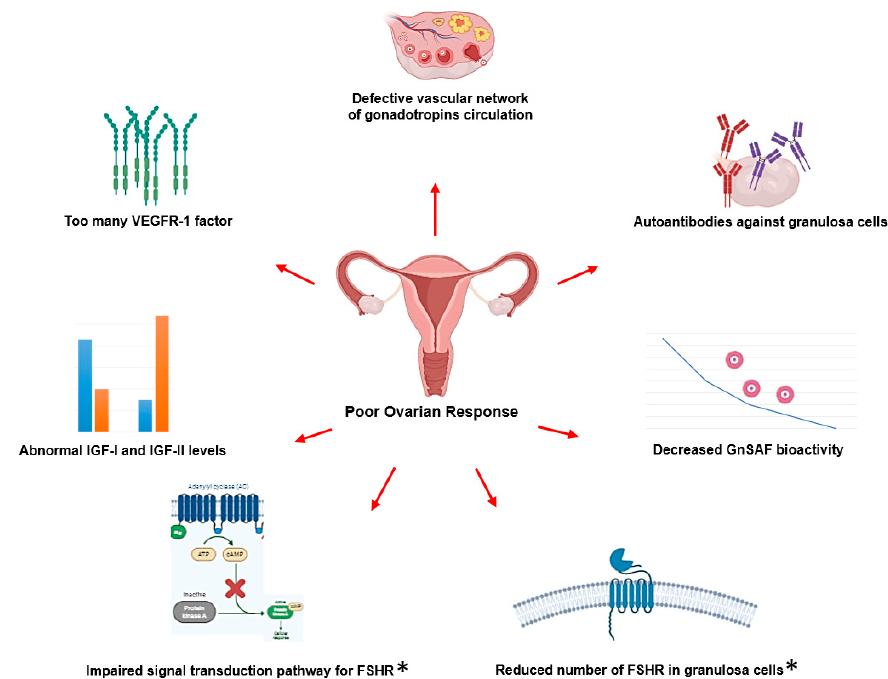
Figure 3. Suggested molecular mechanisms for poor ovarian response in females. The genetic landscape of individuals can potentially affect all of the introduced reasons here. Pharmacogenomic profiling for the reduced number of FSHR and impaired signal transduction pathway of that in patients before the implementation of ovarian stimulation proved to be beneficial in females undergo- ing infertility treatments. *, PGx implication. VEGFR-1: vascular endothelial growth factor receptor 1; IGF-I, II: insulin-like growth factor 1, 2; GnSAF: gonadotropin surge-attenuating